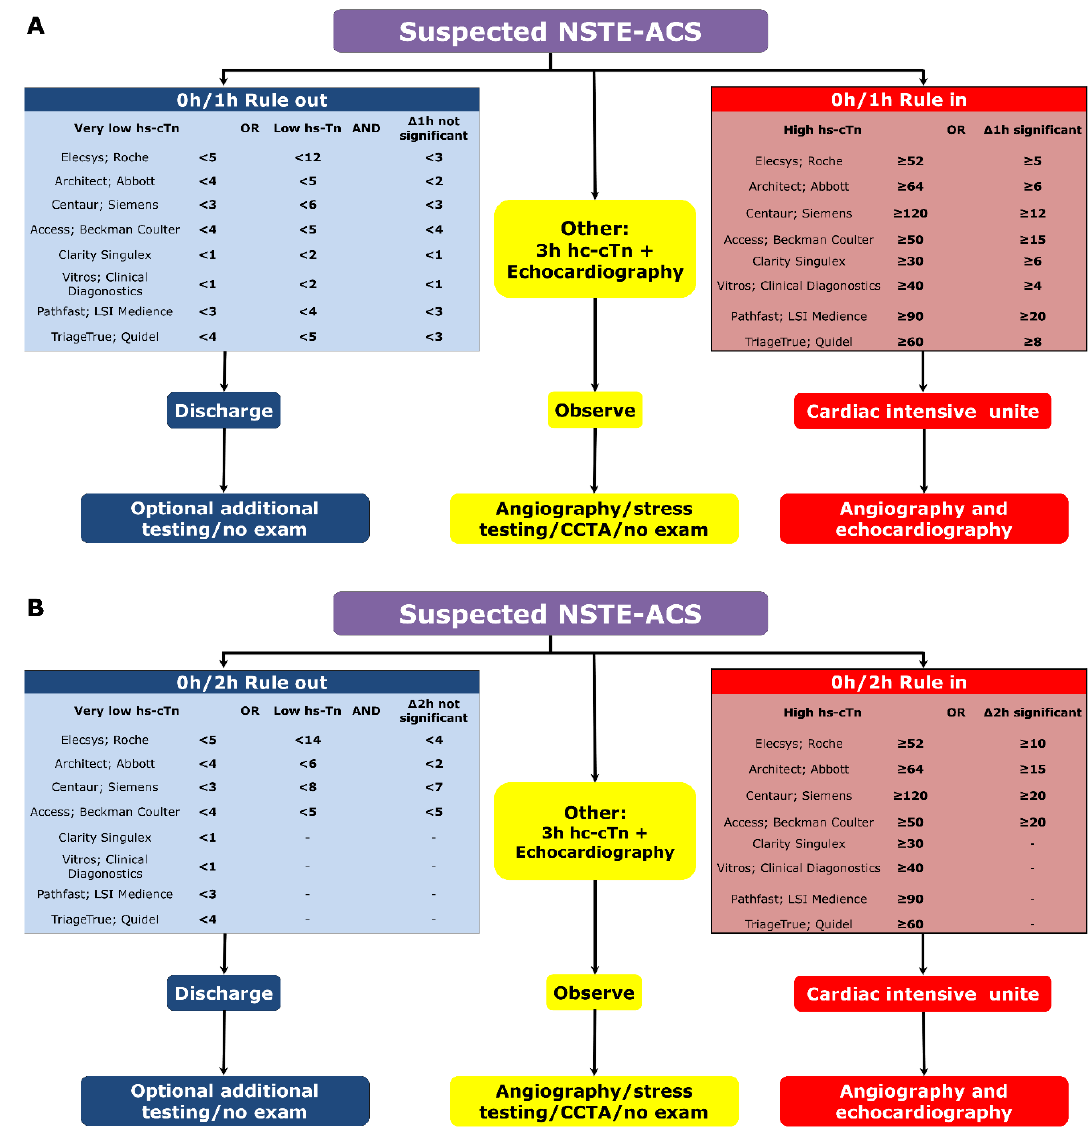
Figure 1. Rule in / Rule out algorithms according to the 2020 ESC NSTEMI guidelines: 0 h / 1 h algorithm ( A ) and 0 h / 2 h algorithm ( B ).STE-ACS: non-ST-segment elevation myocardial infarction; cTn: cardiac troponin; CCTA: coronary computed tomography angiography